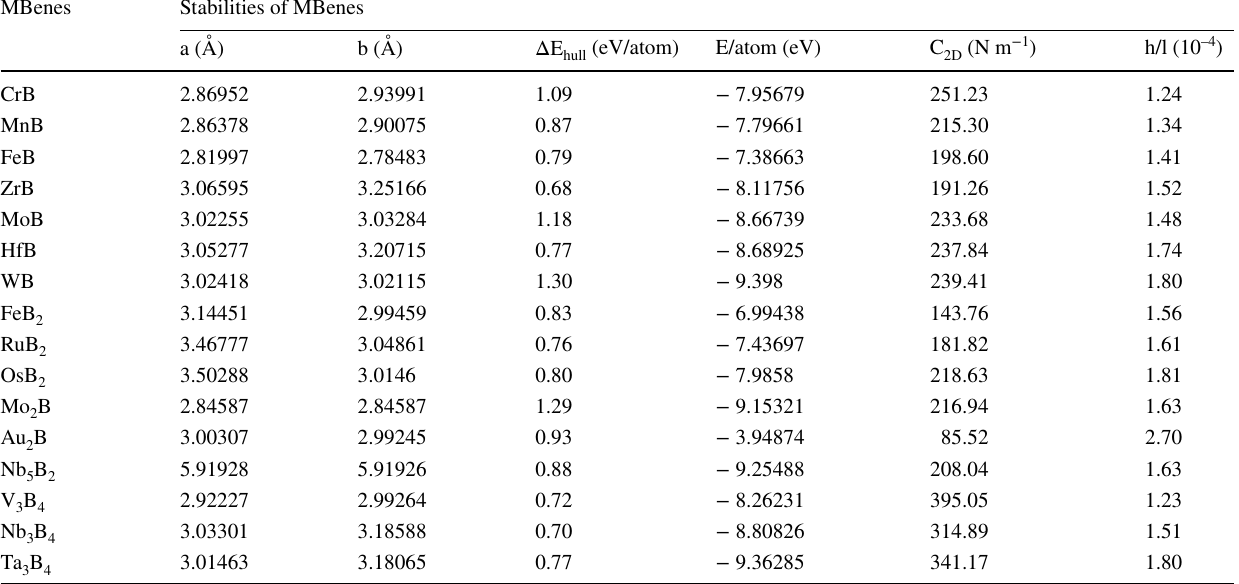
Table 3 Stabilities of MBenes MBenes Stabilities of